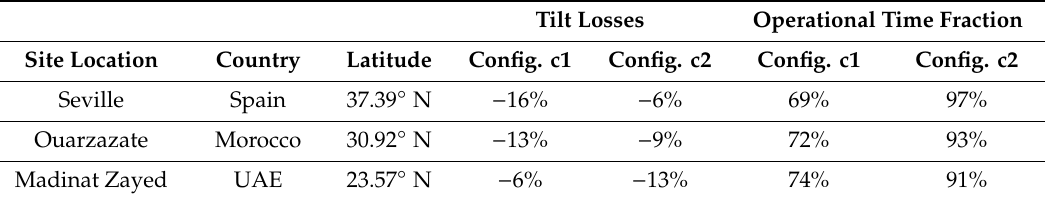
Table 8. Comparison of site locations for Configurations c1 and